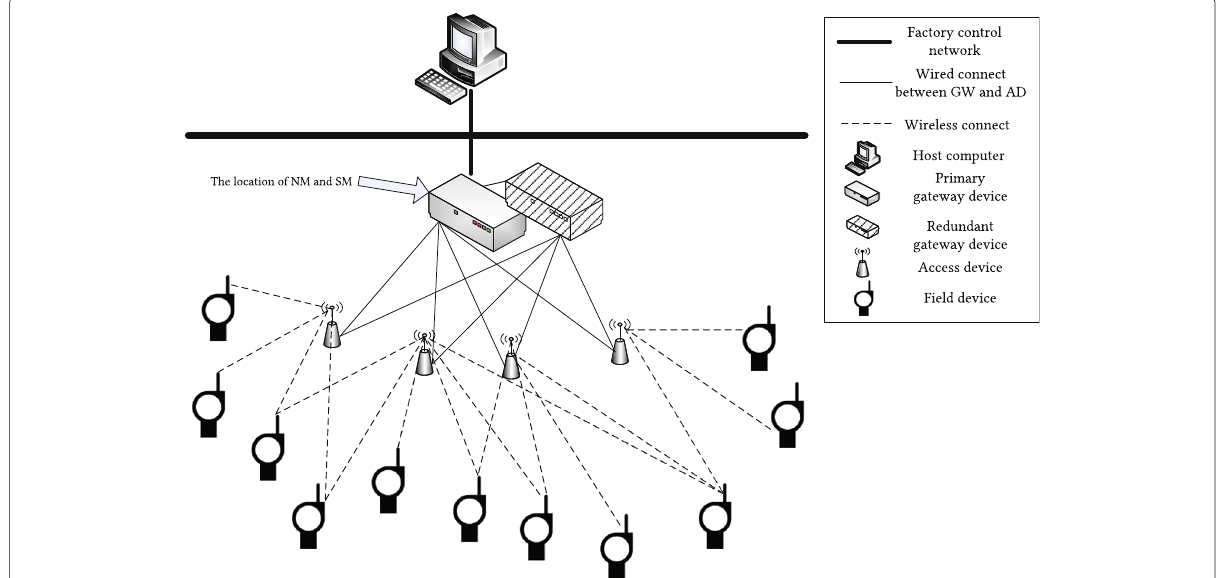
Fig. 1 WIA-FA redundant star topology (legends: NM network manager, SM security manager, GW gateway device, AD access